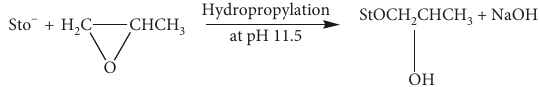
Scheme 6: Hydroxylpropylation of starch with propylene